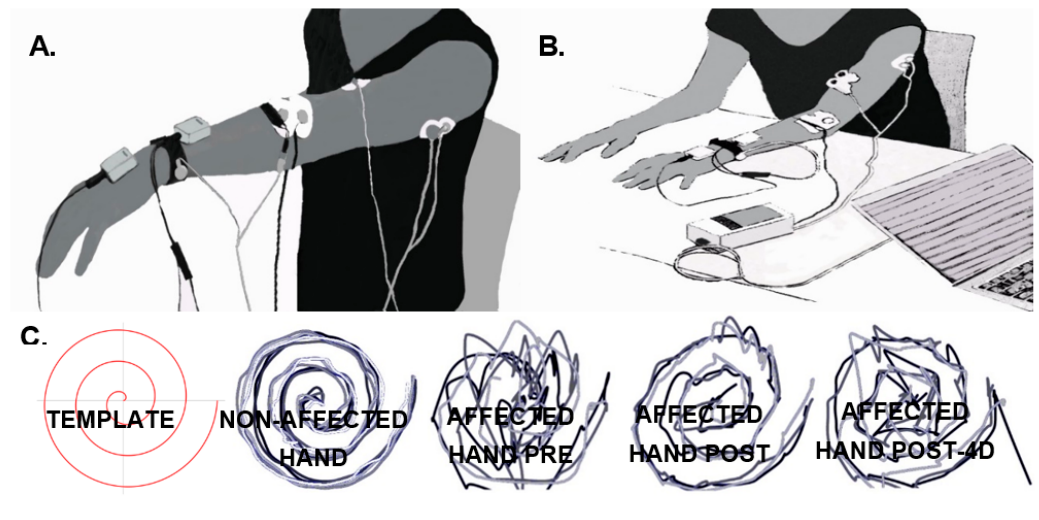
Figure 1. Subject’s posture and position of the sensors for tremor recording using gyroscopes (grey boxes) and electromyography (EMG) (white circular electrode) during the postural task ( A ) and before starting the functional task (9-Hole Peg test (9HPT)). ( B , C ) Superimposition of the Archimedes spiral drawn on a template after placing the finger in the spiral’s center with the assessor’s help with the index finger of the non-affected hand, and the affected hand before (pre), after the intervention (post), and 4 days after the intervention (post-4d), from left to right.